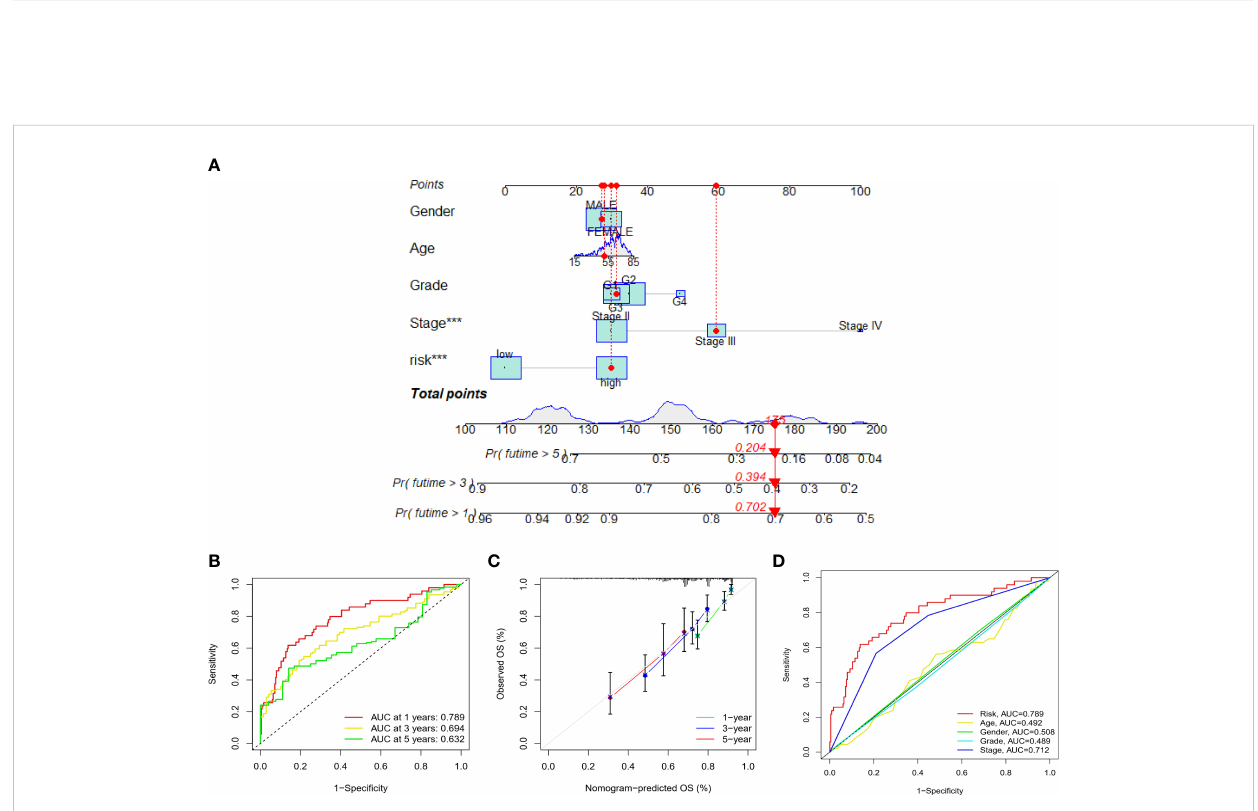
FIGURE 5 (A) Nomogram combining clinicopathological variables and risk scores to predict 1-, 3-, and 5-year overall survival of patients with LIHC (*** P < 0.001). (B) Accuracy of risk characteristics in predicting 1-, 3-, and 5-year characteristic curves, based on the entire set. (C) Calibration curves for 1, 3 and 5 years to test the agreement between actual and predicted results. (D) Predictive accuracy of risk models compared to clinicopathological characteristics such as risk score, age, gender, grade, and stage.